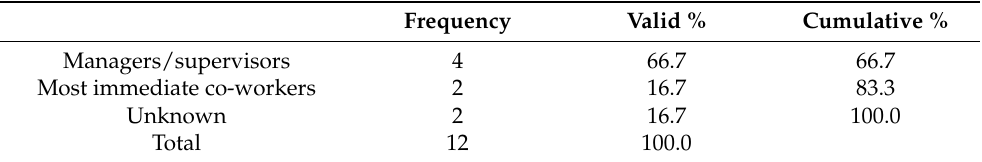
Table 7. Training on disability.